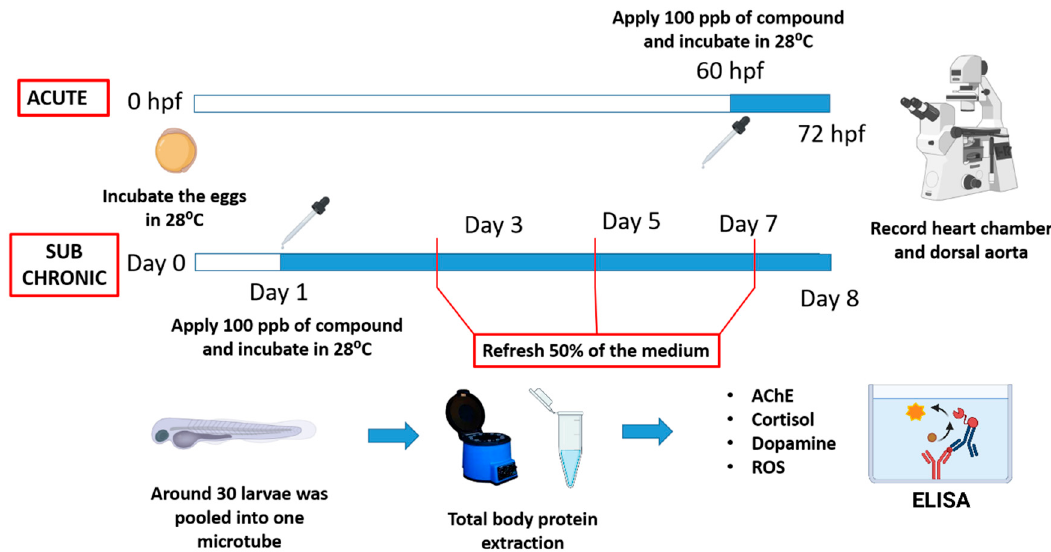
Figure 1. Schematic diagram showing our experimental design for testing cardiovascular physiology (upper panel) and biomarker alteration (lower panel) caused by eight artificial sweeteners in zebrafish embryos. hpf, hour post-fertilization; AChE, acetylcholine esterase; ROS, reactive oxygen species; ELISA, enzyme-linked immunosorbent assay.